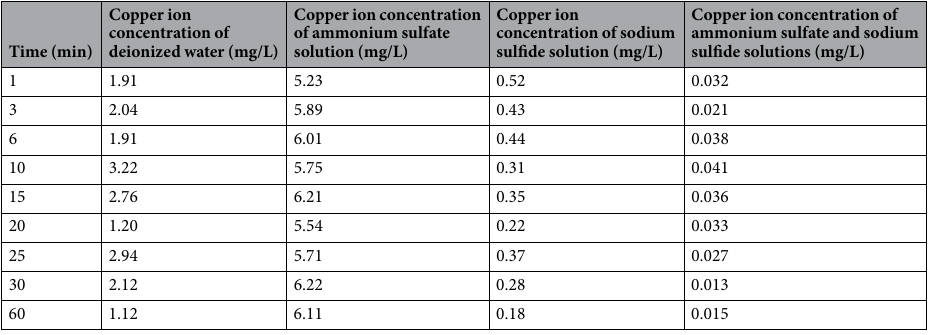
Table 2. Dissolution and time relationship of analysis results of malachite under different